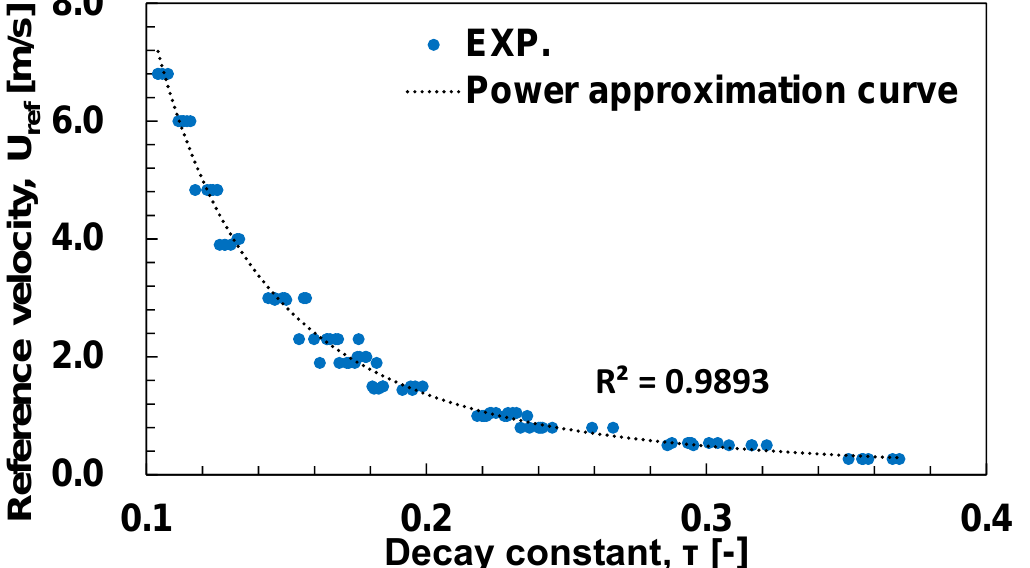
Figure 4. Decay time constant ( 𝜏 ) of temperature transients as a function of reference velocity ( 𝑈 𝑟𝑒𝑓 ).